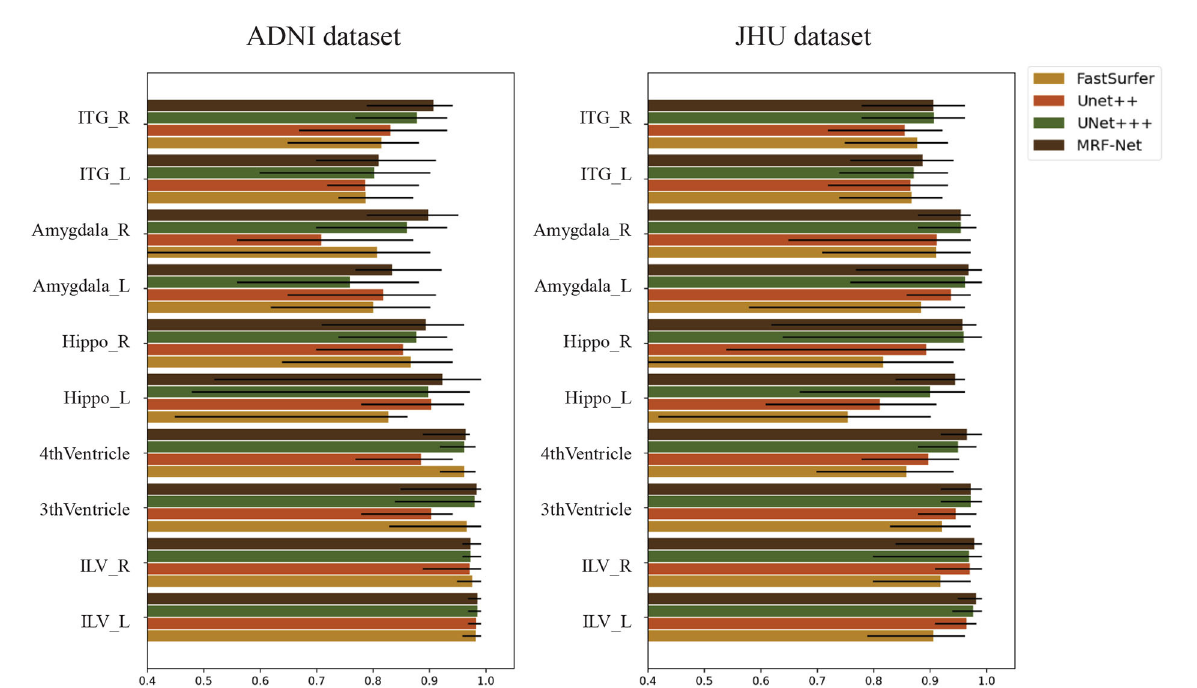
FIGURE6 The intraclass correlation coefficient in terms of segmented structural volume based on four methods on 10 structures. The error bars represent the upper and lower bound of the ICC with a significance level of α = 0.05. ITG, Inferior Temporal Gyrus; Hippo, Hippocampus; ILV, Inferior Lateral Ventricle; L, Left hemisphere; R, Right